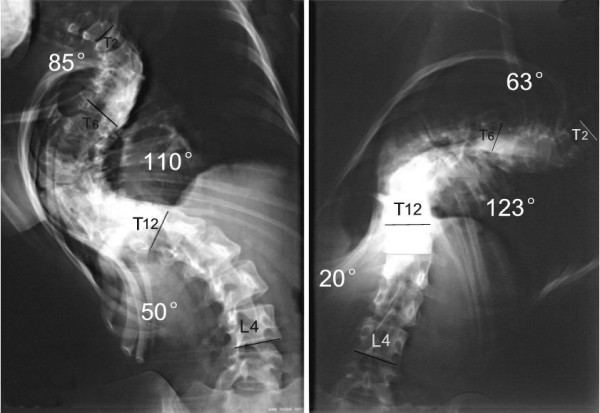
Bending view shows the change of deformity.